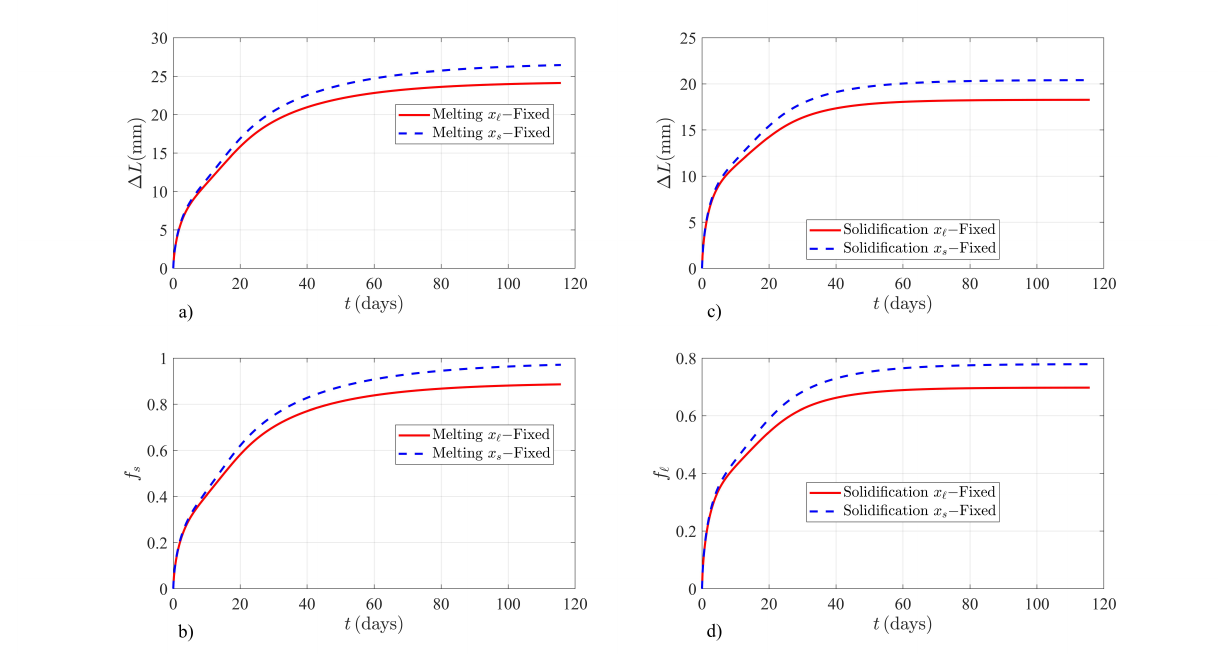
Figure 1. Finite element method solutions to the classical model for a liquid–solid sample of KNO 3 salt subjected to the adiabatic boundary conditions given by Equation (1). ( a ) Time evolution of ∆ L in mm and ( b ) fraction of melted solid f s , for melting of KNO 3 when ξ ( 0 ) = 0.30m. ( c ) System shrinkage ∆ L in mm and ( d ) f (cid:96) , for the solidification case of KNO 3 when ξ ( 0 ) =